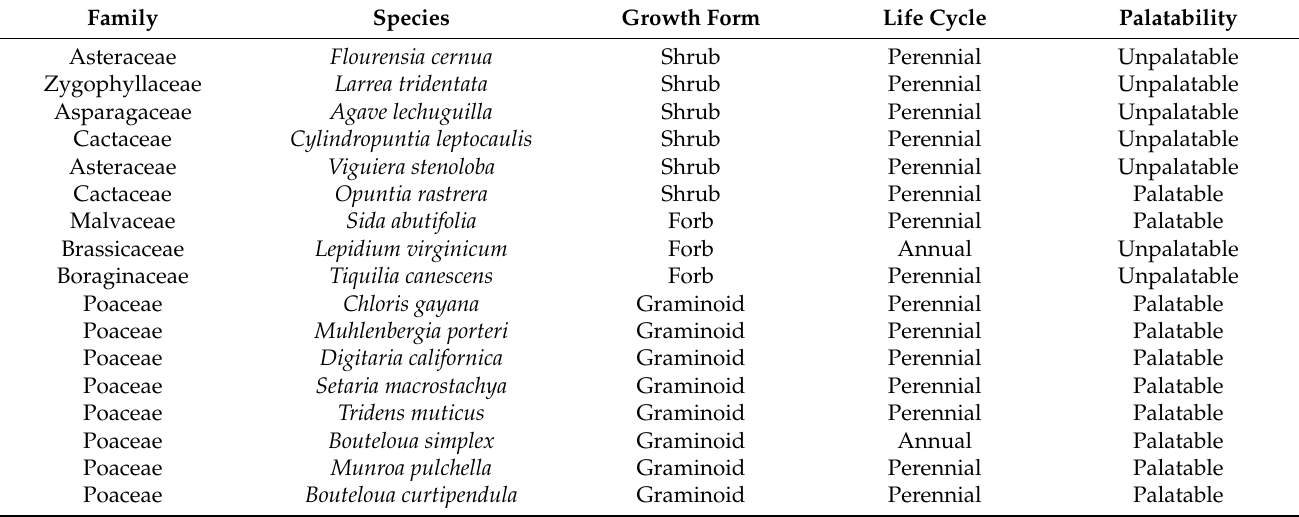
Table A1. Species Characteristics with the Family, Life Cycle and Growth Form indicated As Well As Cattle